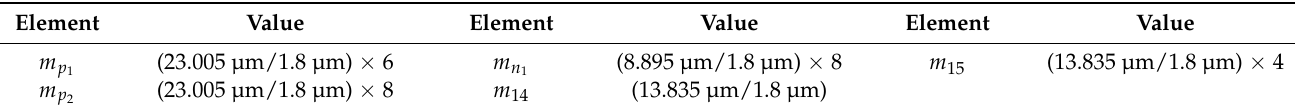
Table 2. Elements and transistor sizes of the current reference.